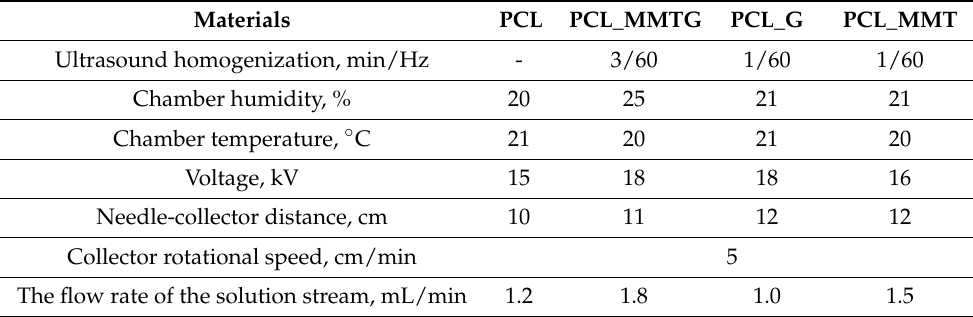
Table 1. Technical data and conditions for obtaining materials by electrospinning. Materials PCL PCL_MMTG PCL_G PCL_MMT Ultrasound homogenization, min/Hz - Chamber humidity, % Chamber temperature, ◦